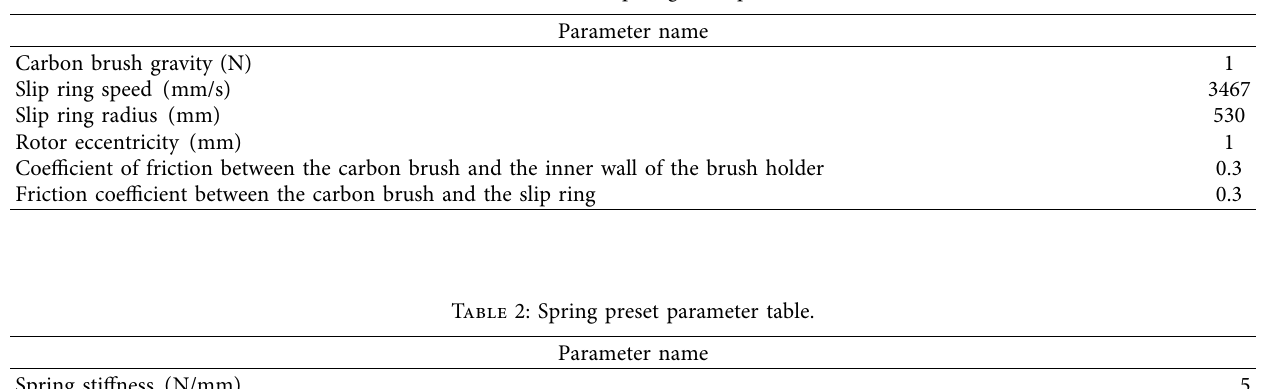
Table 1: Carbon brush/slip ring fixed parameter table.